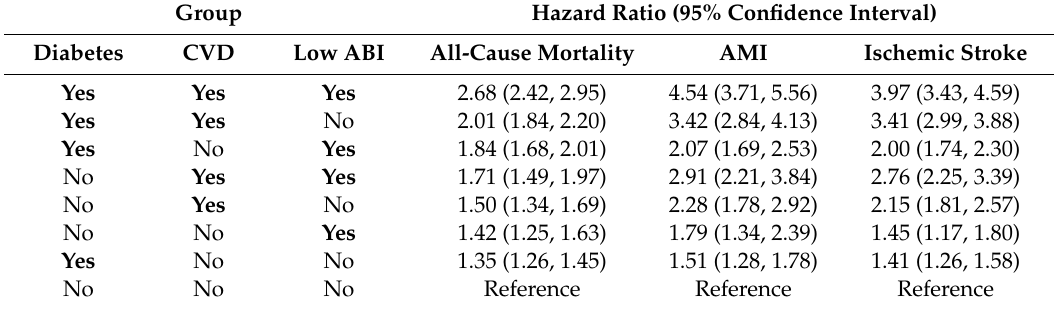
Table A3. Adjusted hazard ratios (95% confidence intervals) for all-cause mortality, acute myocardial infarction, and ischemic stroke, by